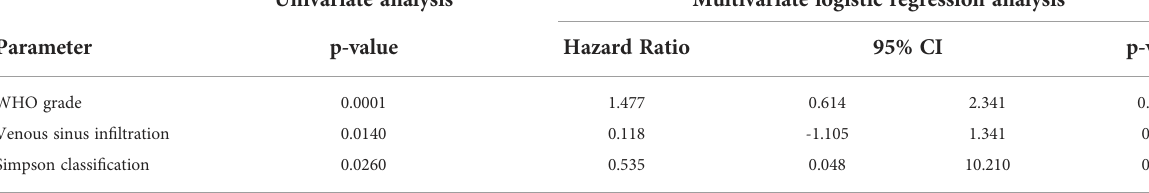
TABLE 5 Univariate (logrank) and multivariate (logistic regression) analysis of factors associated with tumor – speci fi c survival